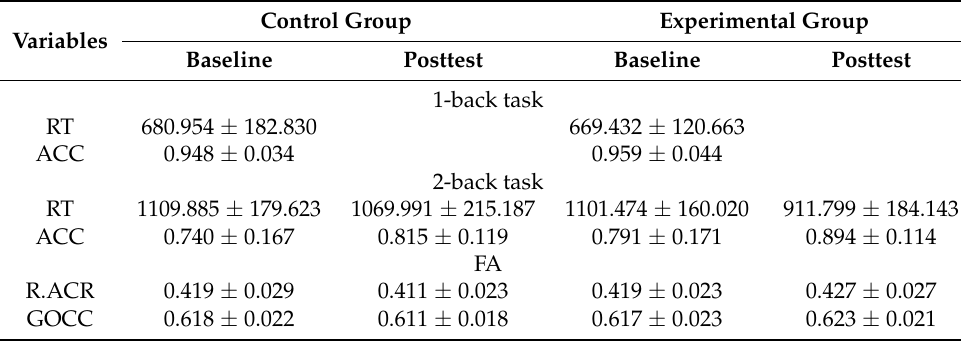
Table 2. Analysis of experimental and control groups for WM and FA (M ±